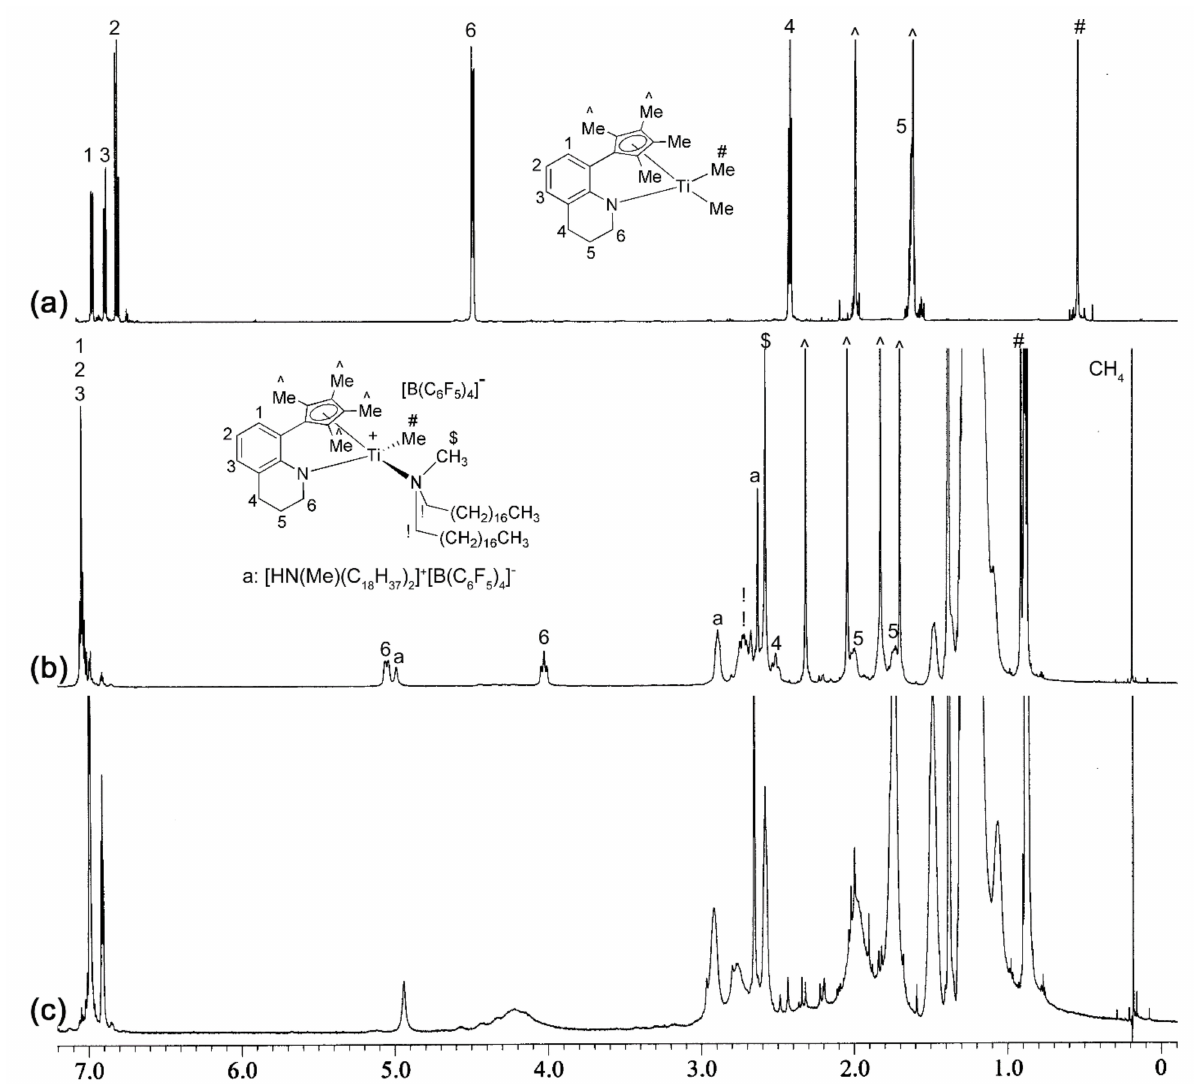
Figure 6. 1 H NMR spectra of 6 -TiMe 2 ( a ) and its activated complex [ 6 -Ti(CH 2 N(C 18 H 37 ) 2 )] + [B(C 6 F 5 ) 4 ] − formed at an initial stage ( b ) and transformed to another species overnight ( c ). Signals marked with !, $, ˆ, and # characters correspond to protons marked with those characters in the